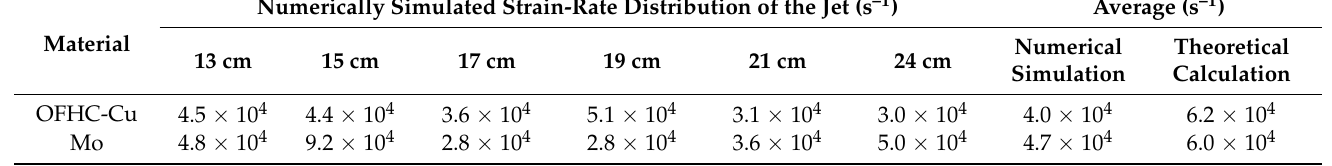
Table 3. Distribution of the deformation strain rate of each jet at 40 µ s and data comparison.